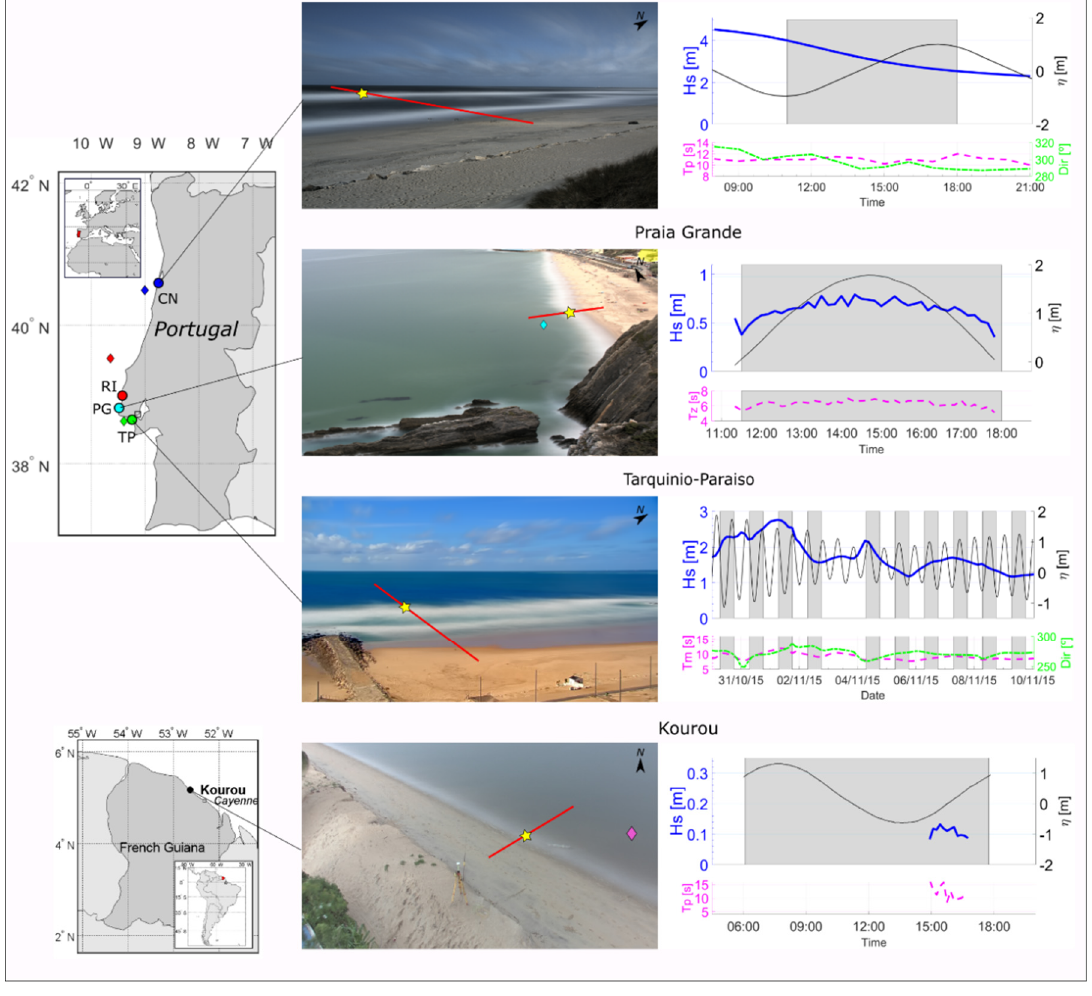
Figure 8. Four study sites for application of Hs b , v 24 method. ( left ) Locations of sites, namely CN (Costa Nova), PG (Praia Grande), and TP (Tarquinio-Paraiso) in relation to RI (Ribeira d’Ilhas, development site), and KO (Kourou). ( middle ) Examples of oblique Timex images (central), with considered transect for sampling I TX and breaking location considered for the application of Hs b , v 24 (yellow pentagram). At PG and KO, diamonds show oceanographic instrumentation deployment position. ( right ) Hydrodynamics during the experiences with time series of water level η , significant wave height Hs , wave period T , and wave direction Dir.